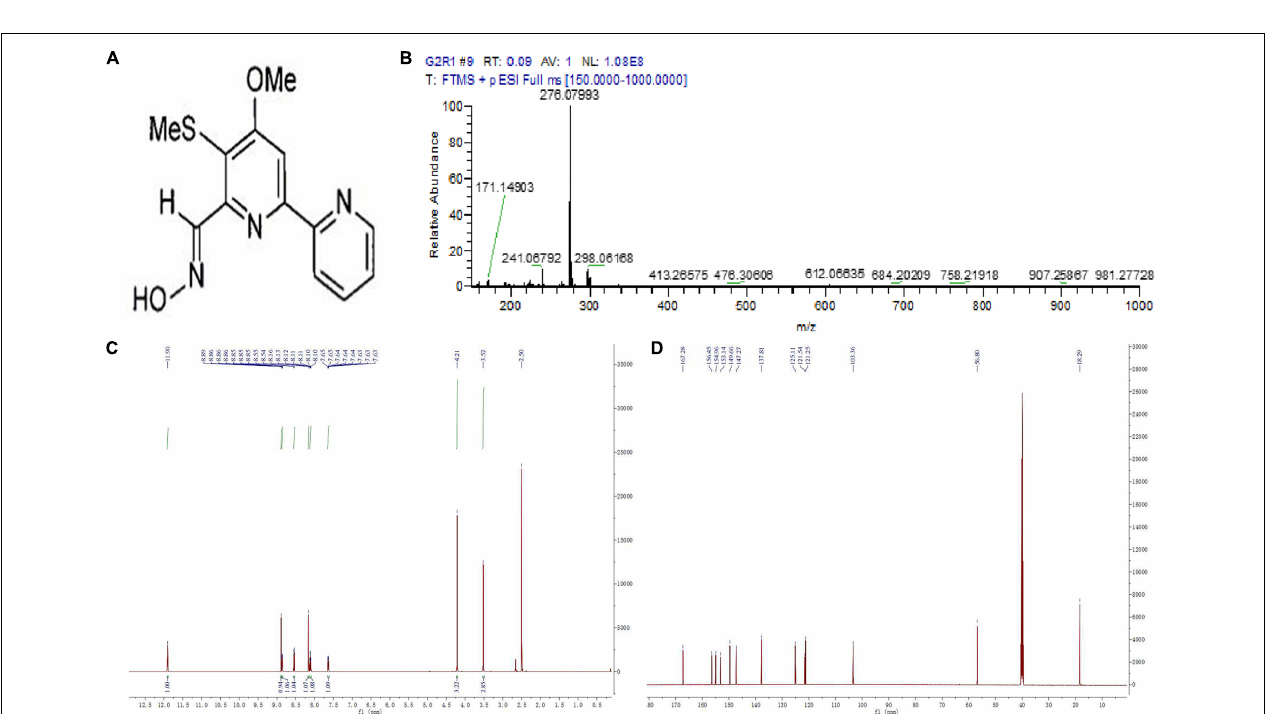
FIGURE 4 | Structure identification of the purified compound 2. (A) Molecular structure of the compound. (B) Mass spectrometry. (C) Proton ( 1 H) nuclear magnetic resonance. (D) Carbon ( 13 C) nuclear magnetic resonance spectrum of the compound 2 in DMOS-6 d .